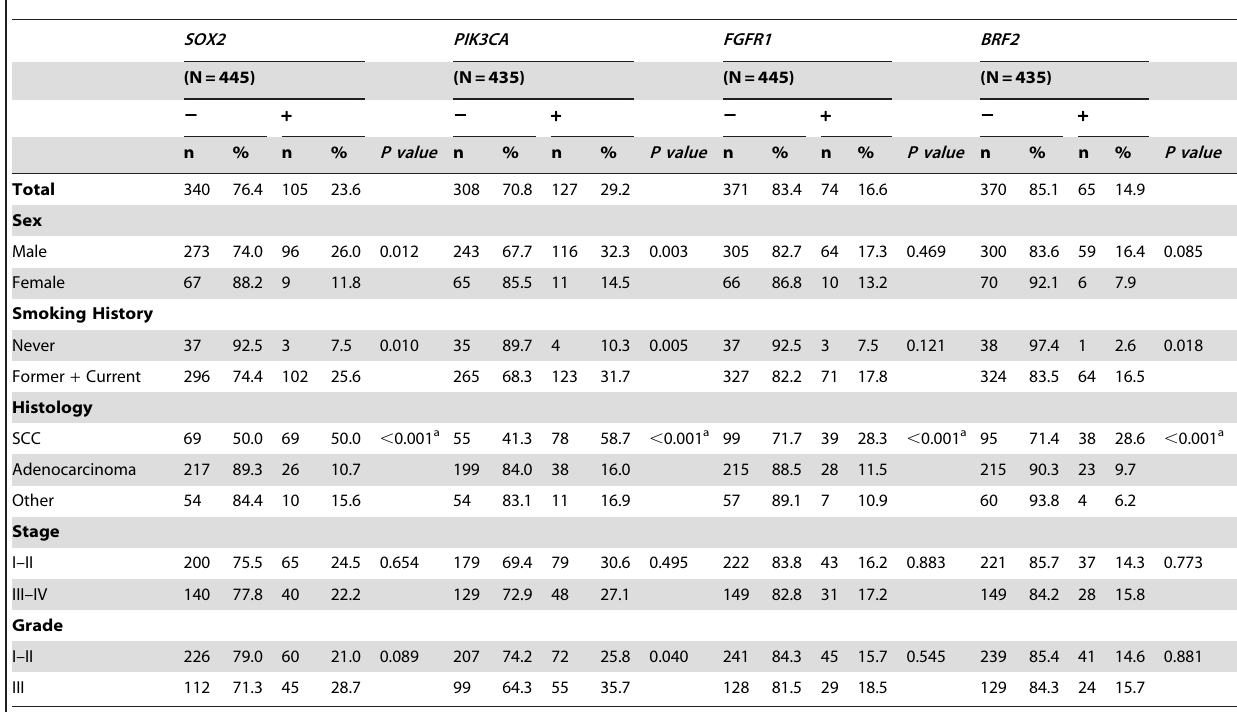
Table 2. Associations between FISH status and patient